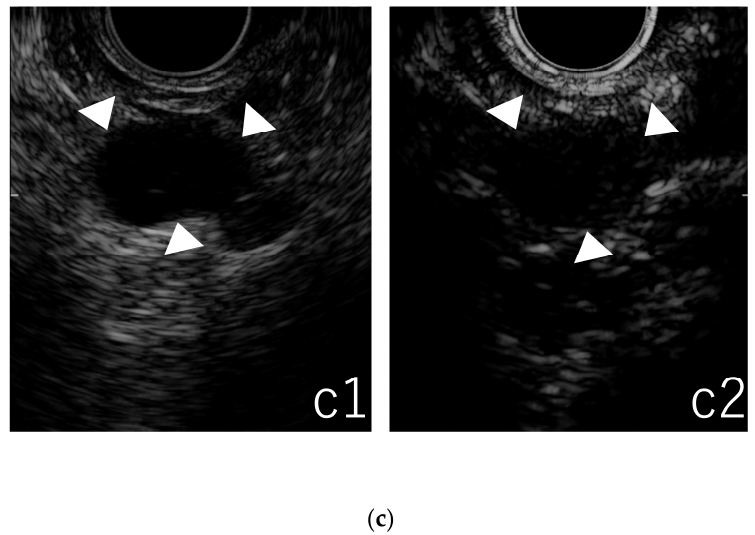
Figure 3. The three patterns of figures for vascular and enhancement patterns of non-Hodgkin’s lymphoma. The white arrow shows each lesion. ( a ) Typical lesion of a lymph node that shows homogeneous enhancement and hypervascular (an indolent non-Hodgkin’s lymphomas; Follicular lymphoma). ( a1 ) fundamental B-mode, ( a2 ) contrast-enhanced mode. ( b ) Typical lesion of a lymph node that shows heterogeneous enhancement and hypervascular (an aggressive non-Hodgkin’s lymphomas; diffuse large B-cell lymphoma). ( b1 ) Fundamental B-mode, ( b2 ) contrast-enhanced mode. ( c ) Typical lesion of a lymph node that shows heterogeneous enhancement and hypovascular (an aggressive non-Hodgkin’s lymphomas; diffuse large B-cell lymphoma) ( c1 ) fundamental B-mode, ( c2 ) contrast-enhanced mode. Table 3. The vascular and enhancement patterns of non-Hodgkin’s lymphoma in mediastinal or abdominal cavity.